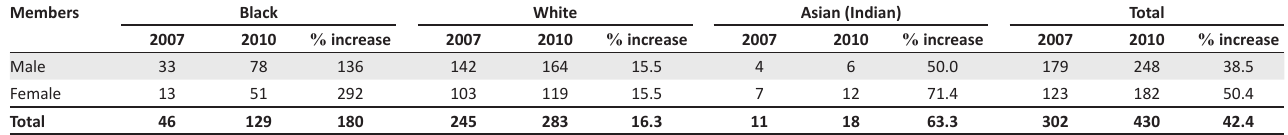
TABLE 2: Number of SASA members by race and gender in 2007 and 2010.